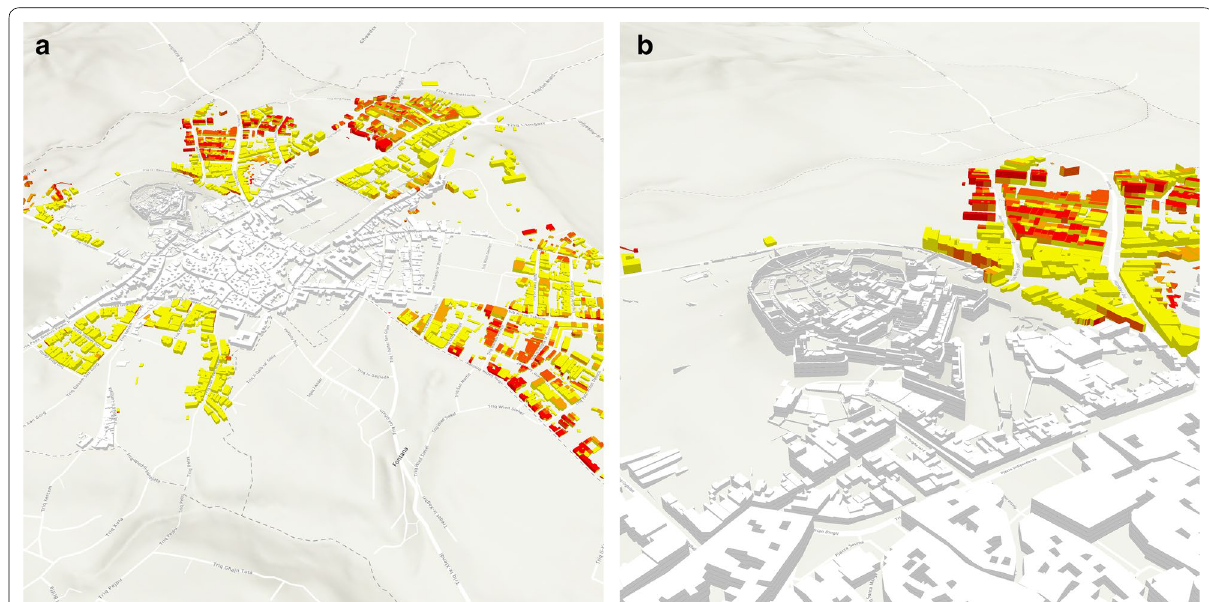
Fig. 6 a Visible area percentage: very low visibility (yellow); low visibility (light orange); average visibility (dark orange); high visibility (red). Victoria now. b Visible area percentage: very low visibility (yellow); low visibility (light orange); average visibility (dark orange); high visibility (red). Victoria now